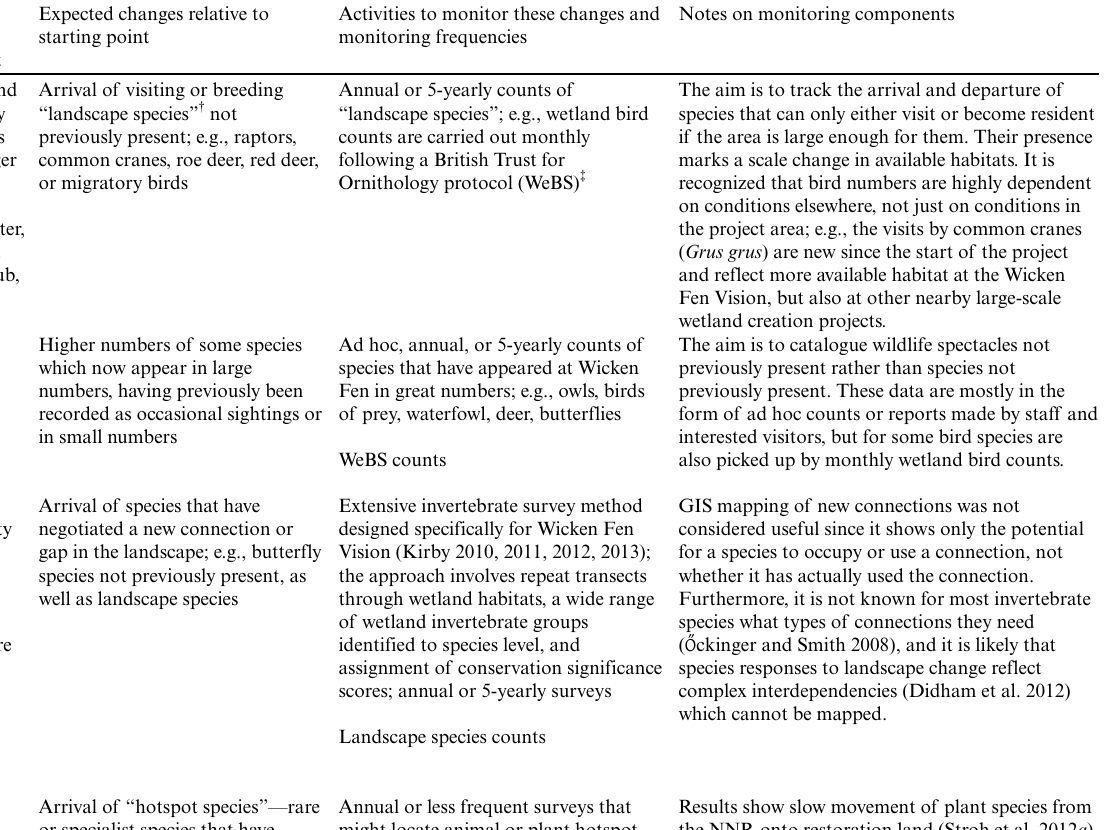
Table 1 . Landscape-scale restoration project monitoring protocols at the Wicken Fen Vision Project (developed from Hughes et al. 2011). Characteristic of